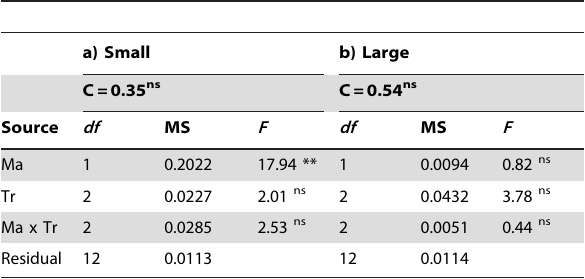
Table 1. Analyses of proportion of survival of a) small or b) large